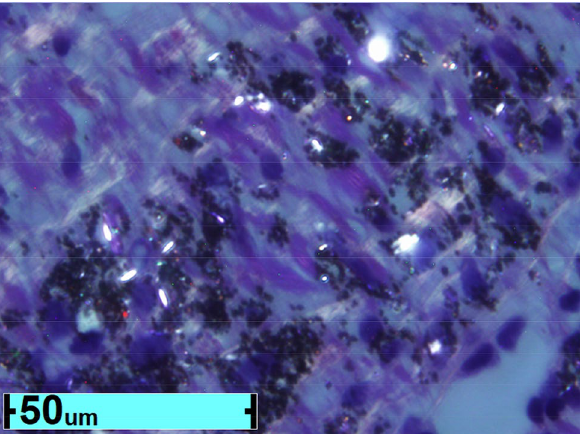
Figure 1. Representative lung biopsy from soldier exposed to burn pits has black carbonaceous particles and white refractile dust crystals amidst fibrosis. These black and white particles have polycyclic aromatic hydorcarbons and contain oxidized metals titanium and